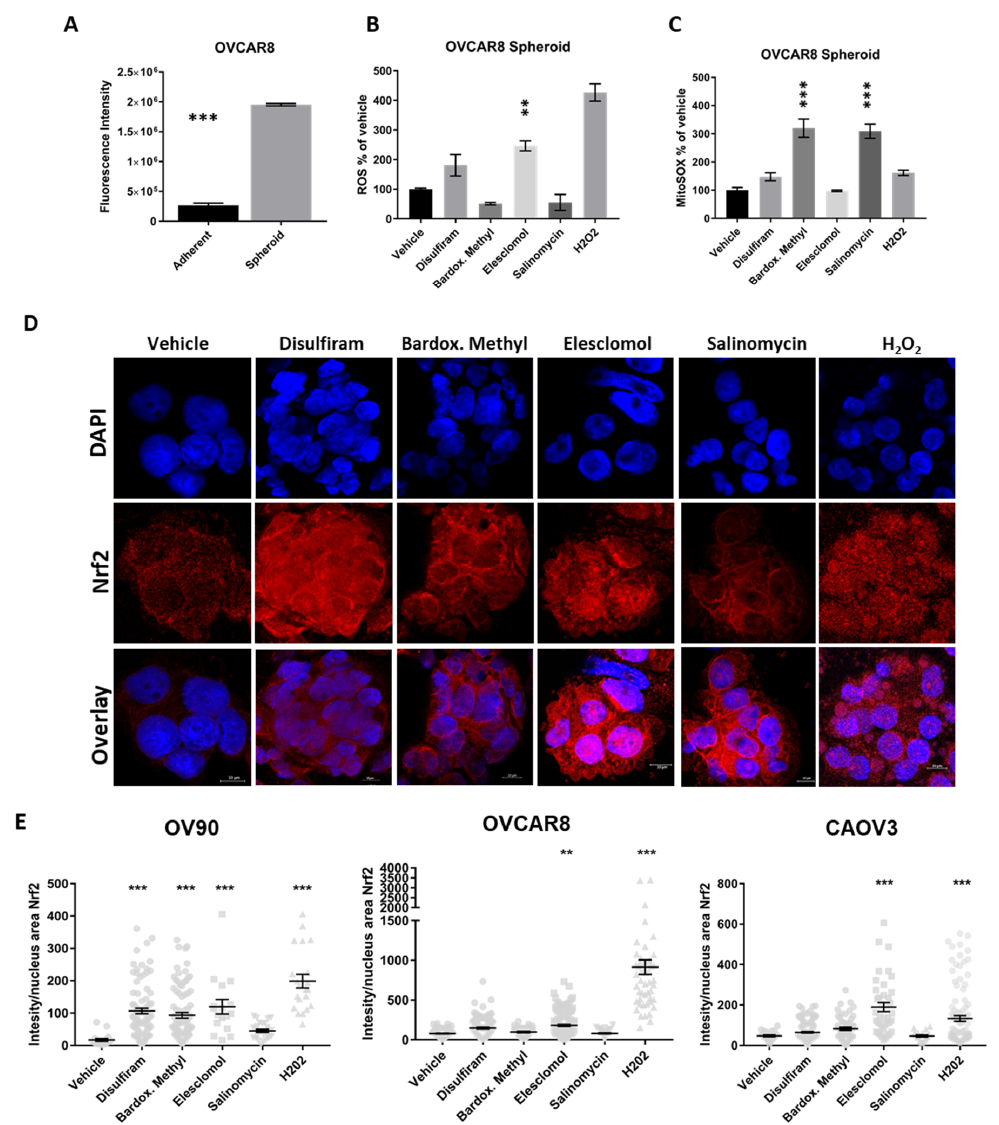
Figure 5. Candidate drugs cause oxidative stress in OC spheroids. ( A ) Ovcar8 cells grown in TIC-enriching spheroid conditions have significantly higher levels of ROS compared to adherent Ovcar8. ( B ) Ovcar8 spheroids treated with the drugs at LD50 for 6h showed elesclomol produced higher levels of intracellular ROS compared to vehicle. ( C ) Ovcar8 spheroids treated with LD 50 concentrations of the drugs were analyzed for MitoSOX levels. Bardoxolone methyl and salinomycin for 6 h showed increased MitoSOX compared to control. ( D ) Representative images of Nrf2 (red) translocation to the nucleus (blue, DAPI) in OV90 spheroids after 6h treatment with each of the drugs at respective LD50 doses. 63X objective, scale bar is 10µm. ( E ) Quantification of Nrf2 nuclear localization in each cell line treated with each of the drugs for 6h. Graphs represent mean and SEM compared to control ** p < 0.01, *** p < 0.001.